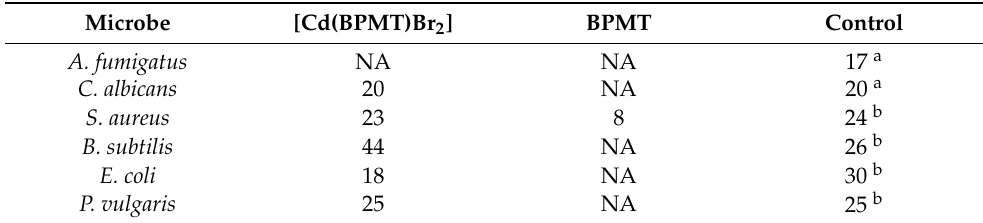
Table 4. Zone of inhibition (mm) for BPMT and the [Cd(BPMT)Br 2 ] complex.